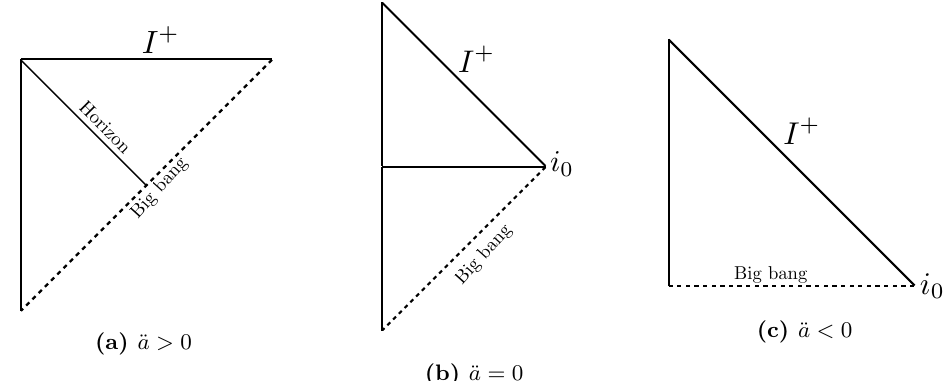
Figure 4. Penrose diagrams for flat FRW cosmologies with ¨ a > 0 , ¨ a = 0 , and ¨ a < 0 . Figures adapted from [19, 30,